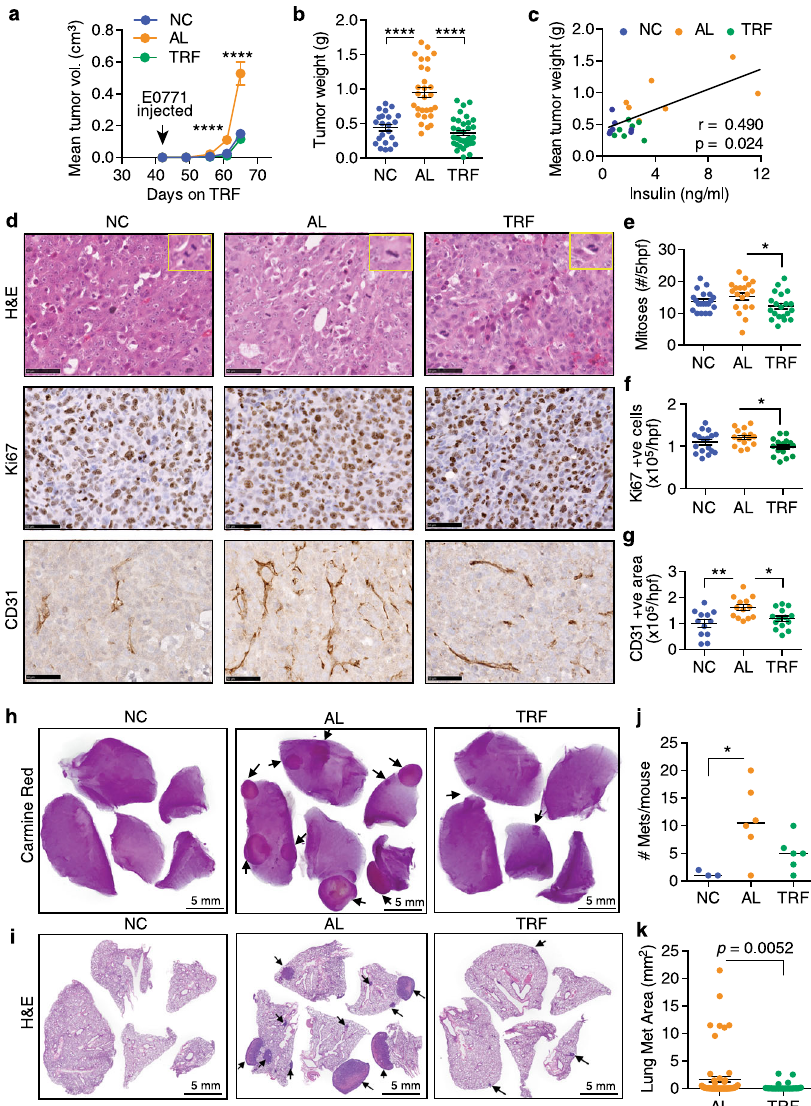
Fig. 3 TRF attenuates E0771 mammary tumor growth and metastasis to lung in obese OVX mice. a E0771 tumor volume over time in OVX mice on NC, AL, and TRF (number of mice n = 7 for NC, n = 7 for AL, n = 9 for TRF; **** p < 0.0001 by two-way ANOVA with Tukey ’ s multiple comparisons test). b Individual tumor weight at sacri fi ce (number of tumors n = 22 for NC, n = 28 for AL, n = 34 for TRF). **** p < 0.0001 by one-way ANOVA with Tukey ’ s multiple comparisons test. c Correlation plot of mean tumor weight per mouse vs. fasting insulin (number of mice n = 7 for NC, n = 7 for AL, n = 7 for TRF). Data were analyzed by linear regression using Pearson correlation. d Representative H&E, Ki67, and CD31 staining of E0771 tumor tissue in OVX mice on NC, AL, and TRF. Scale bar, 50 µ m. Insets in H&E images show higher magni fi cation of a mitotic cell. Data shown are representative of two independent experiments. e – g Quanti fi cation of mitoses ( n = 20 sections for all groups), Ki67-positive cells ( n = 17 for NC, n = 15 for AL, n = 16 for TRF), and CD31- positive cells ( n = 12 for NC, n = 13 for AL, n = 14 for TRF) in sections of E0771 tumor tissue. Data are presented as mean ± SEM per high-powered fi eld (hpf) or 5 hpf for mitoses, with 4 hpf per section ( n = number of tumors). Asterisks indicate signi fi cance; * p < 0.05, ** p < 0.01 by one-way ANOVA with Tukey ’ s multiple comparisons test. h Carmine Red staining of whole-mount lungs showing macro-metastases of E0771 tumor cells. i H&E stained lung sections showing metastases of E0771 tumor cells. Data shown are representative of two independent experiments. j Total number of metastases per mouse (number of mice n = 3 for NC, n = 6 for AL, n = 6 for TRF; * p < 0.05 by one-way ANOVA with Tukey ’ s multiple comparisons test). k Cross- sectional area of individual lung metastases (number of mice n = 3 for NC, n = 6 for AL, n = 6 for TRF; two-tailed t test). Data are presented as mean ± SEM. For a , c , h , and j , n represents number of mice per group. Asterisks show statistical signi fi cance TRF vs AL or as